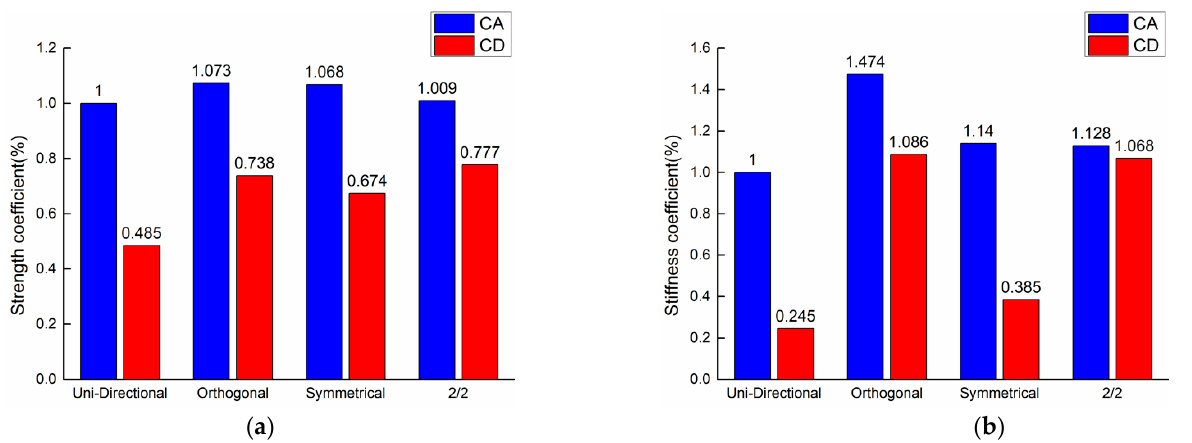
Figure 11. Comparison of the bending performance of materials with different laying method. ( a ) Strength coefficient. ( b ) Stiffness coefficient.